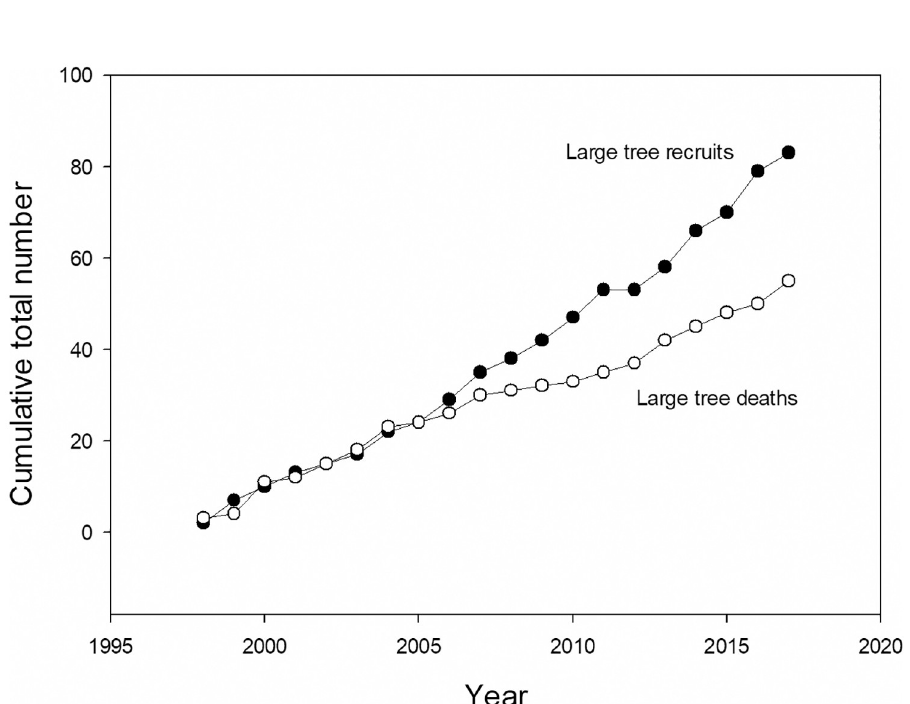
Fig 4. Dynamics of large trees. The cumulative number of large tree recruits and deaths for 18 0.50 ha CARBONO plots.